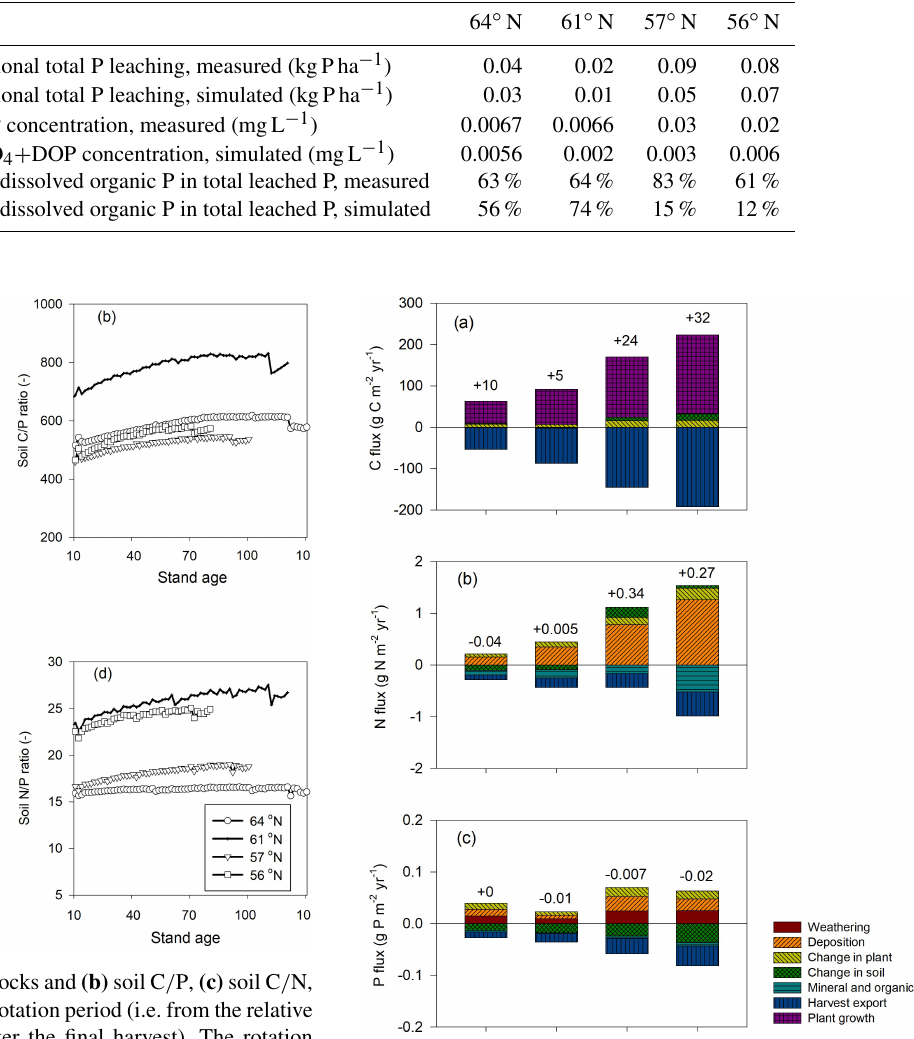
Table 6. Simulated and measured annual P losses through leaching. Measured total phosphorous (TP) is larger than the simulated DOP and PO 4 fraction due to the presence of particulate phosphorus and because the measured value contains P leaching from upstream sources.